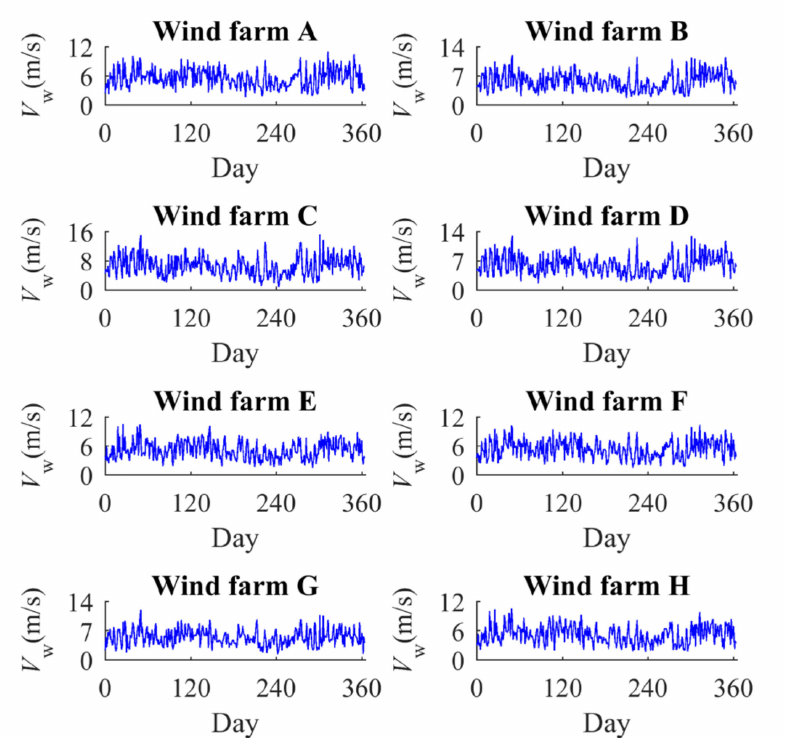
Figure 15. Wind speeds of wind farms from Shandong Province for a year, data taken from NASA [26].